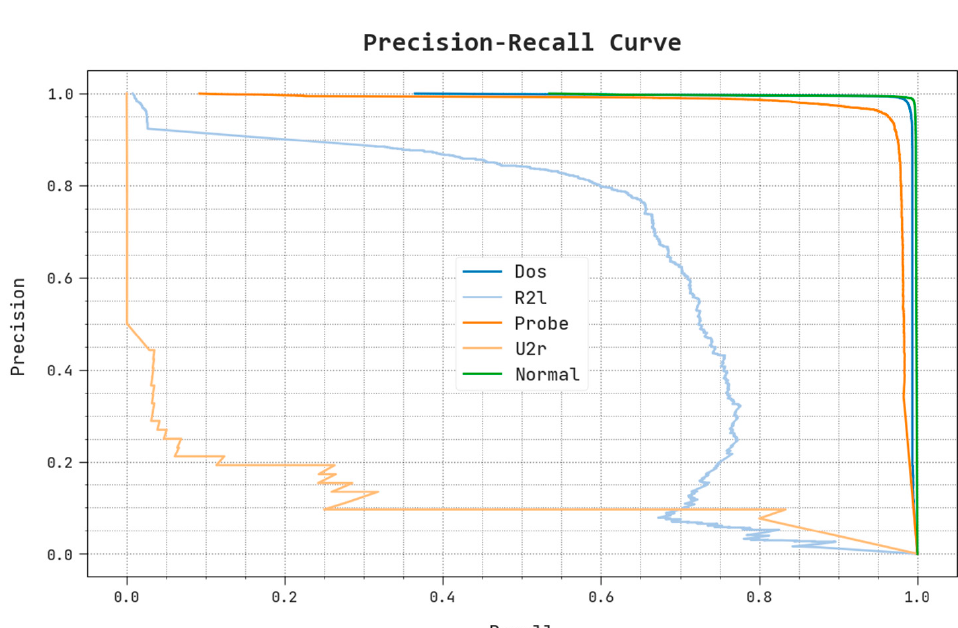
Figure 7. TLS and VLS analysis of IMFL-IDSCS system.